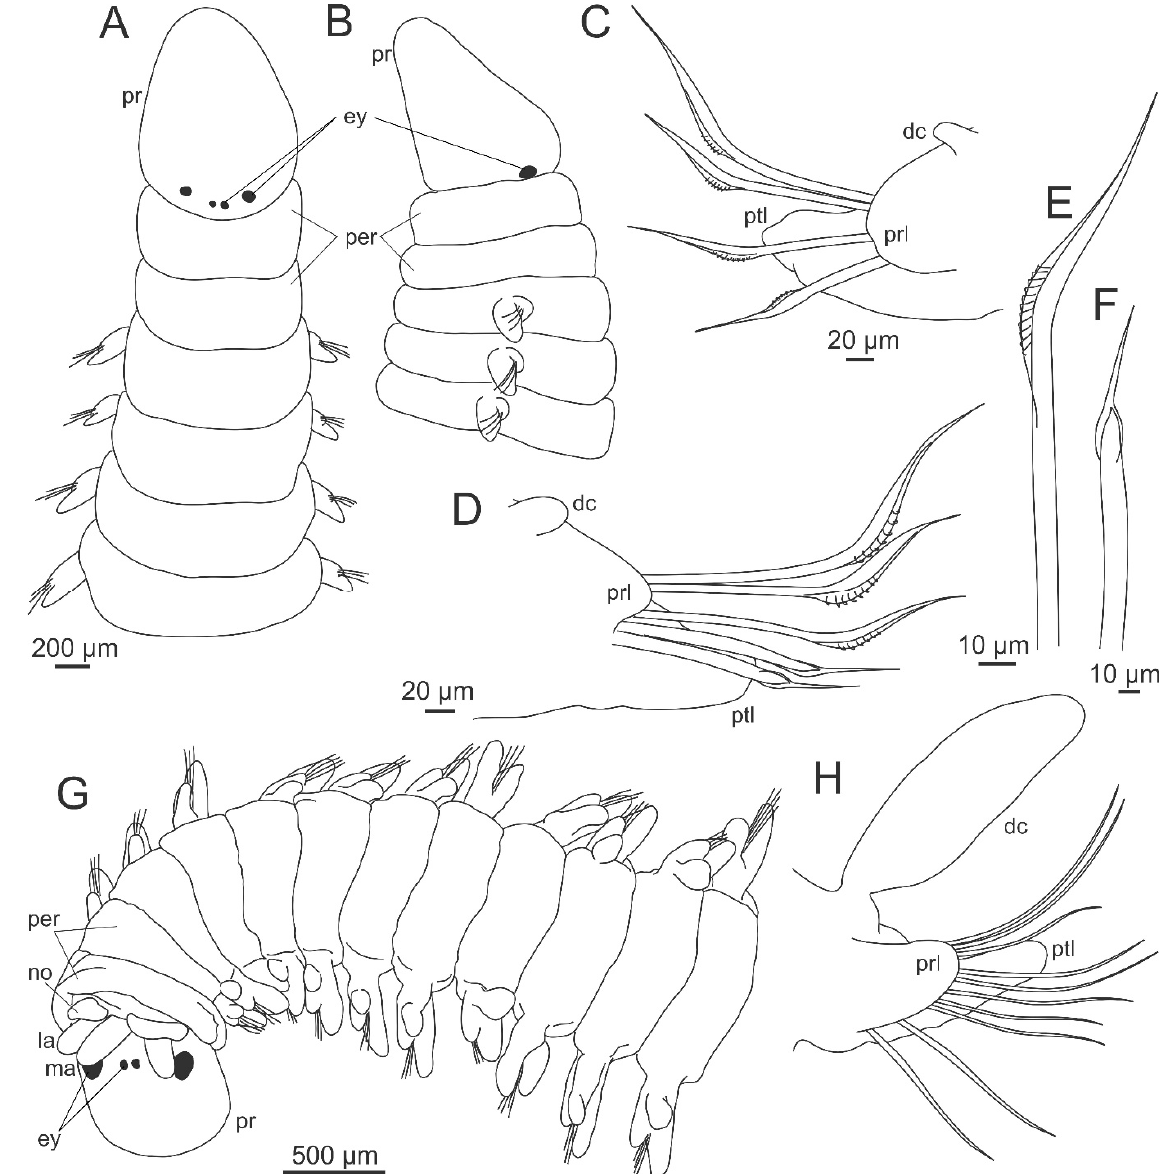
Figure 9. Morphology of Oenonidae. ( A ) Arabella mutans (Chamberlin, 1919), anterior end, dorsal view; ( B ) the same, lateral view; ( C ) the same, parapodium 5; ( D ) the same, parapodium 26; ( E ) the same, limbate chaeta; ( F ) the same, chaetae tapering abruptly to guards ( G ) Oenone fulgida , anterior end, dorsal view; ( H ) the same, parapodium from midbody region. dc– dorsal cirrus, ey–eye, la–lateral antenna, ma–median antenna, no–nuchal organ, per–peristomium, pr–prostomium, prl–prechaetal lobe, ptl–postchaetal lobe. ( B – F ) modified from Zanol and Ruta [365].